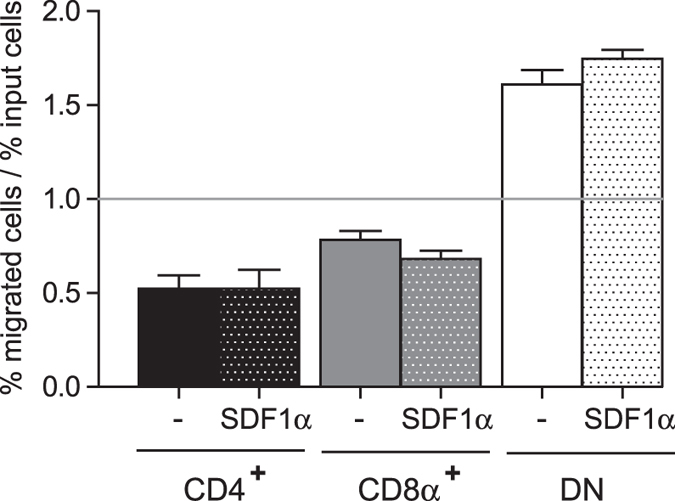
Migratory properties of spleen cDC subsets.CD11c+ spleen cells of ASB2+/+ mice were plated into transwell inserts and allowed to chemotax towards medium containing or not SDF1α, as indicated. After 2 hours at 37 °C, migrated cells were recovered from the wells and quantified by flow cytometry together with input cells. For each cDC subset, the ratio between the percentage of migrated cells and the percentage of input cells as well as SEM of three independent experiments are shown (sample size = 16). The line indicates the 1:1 ratio achieved where all cDC subsets migrate with equal efficiency.